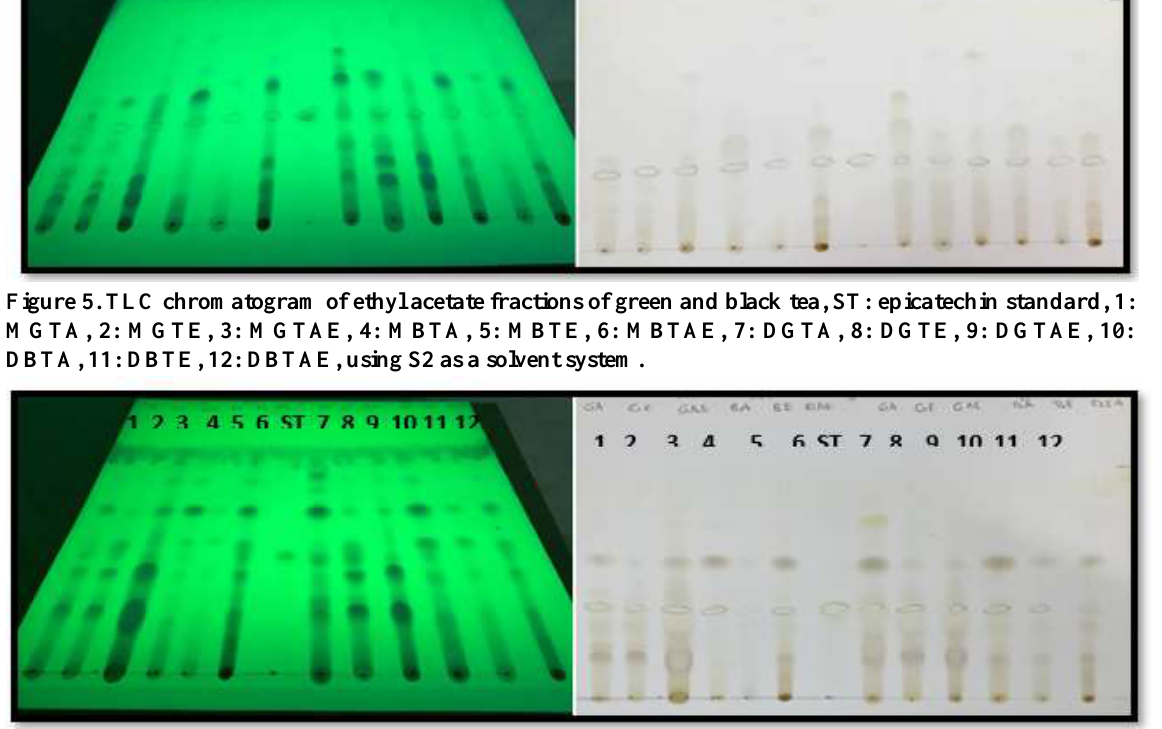
Figure 6. TLC chromatogram of ethyl acetate fractions of green and black tea, ST: epicatechin standard, 1: MGTA, 2: MGTE, 3: MGTAE, 4: MBTA, 5: MBTE, 6: MBTAE, 7: DGTA, 8: DGTE, 9: DGTAE, 10: DBTA, 11: DBTE, 12: DBTAE, using S3 as a solvent system.